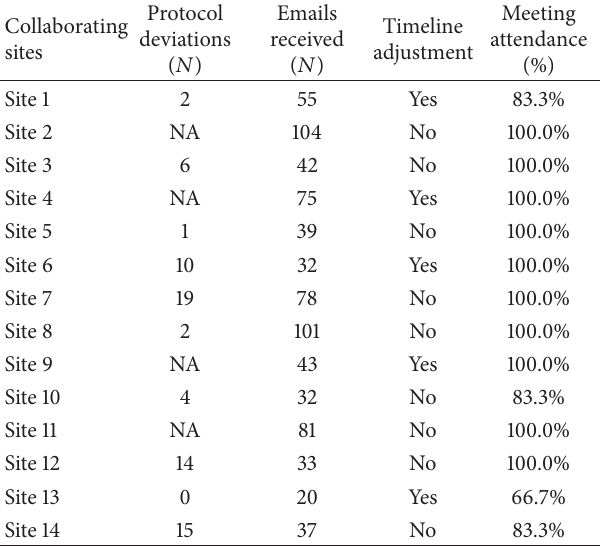
Table 2: Protocol deviations, emails received, and timeline adjust- ments.